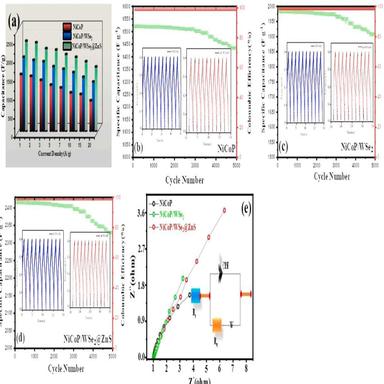
(a) Specific capacitance and current density of as made electrodes. Cyclic performance and coulombic efficiency of (b) NiCoP (c) NiCoP/WSe2 and (d) NiCoP/ WSe2/ZnS. (e) Nyquist plots of different samples.